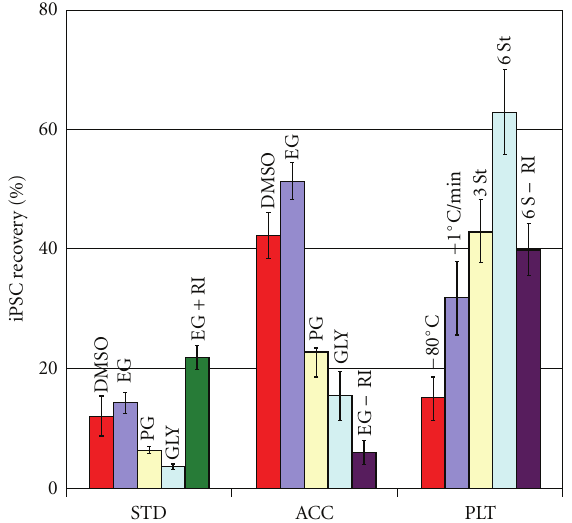
Figure 2: Recovery of viable iPSCs after di ff erent protocols of cryopreservation. Freezing of iPSC 3 was performed using 3 basic protocols: STD: standard routine slow uncontrolled freezing of small clumps with 10% of CPA in Nunc cryovials, ACC: dissociation of the cells with Accutase and freezing in cryovials and freezing and re-plating in the presence of a ROCK Inhibitor Y-27632 (RI), PLT: Freezing of adherent cells in 4-well plates in EG. Four CPAs were used in STD and ACC experiments, which are abbreviated above. The cells in ACC and PLT were frozen and recovered after thawing in the presence of RI. The numbers on the last group indicates programmed freezing protocols described in Section 3.3 and in Figure 4. Fluorescent microphotographs of some of experimental variations are shown on Figures 3 and 4. M ± m , n = 3.